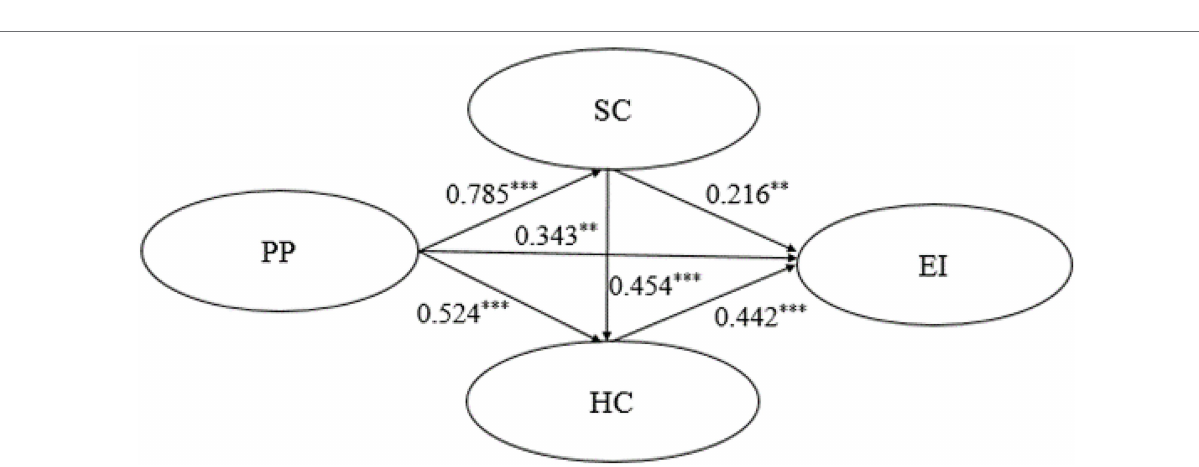
FIGURE 2 | Main effect of the PP on EI. *** p < 0.001; PP, Proactive Personality; EI, Entrepreneurial Intention.